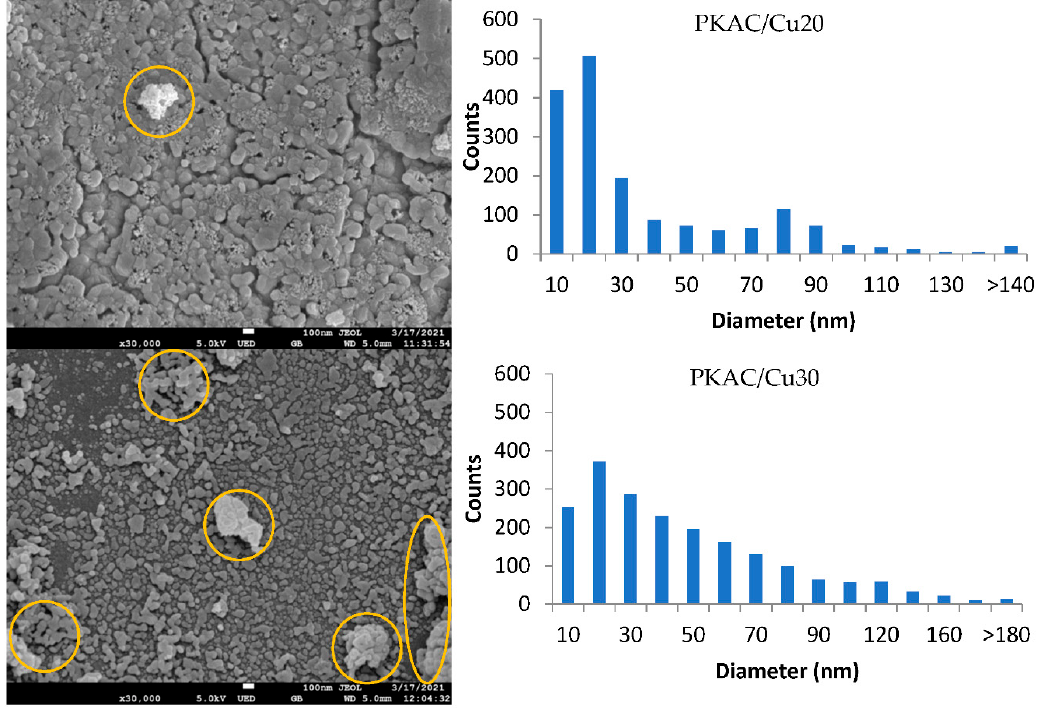
Figure 3. FESEM image and particle size distribution for higher loading monometallic catalysts at 30k magnification.